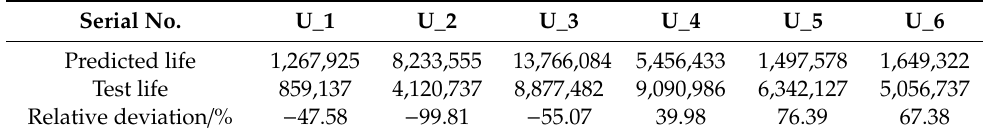
Table 11. Predicted life N 3 derived from measured